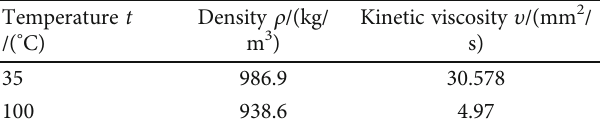
Table 9: Density and kinetic viscosity. Table 10: Dynamic viscosity and density for air and the lubricating